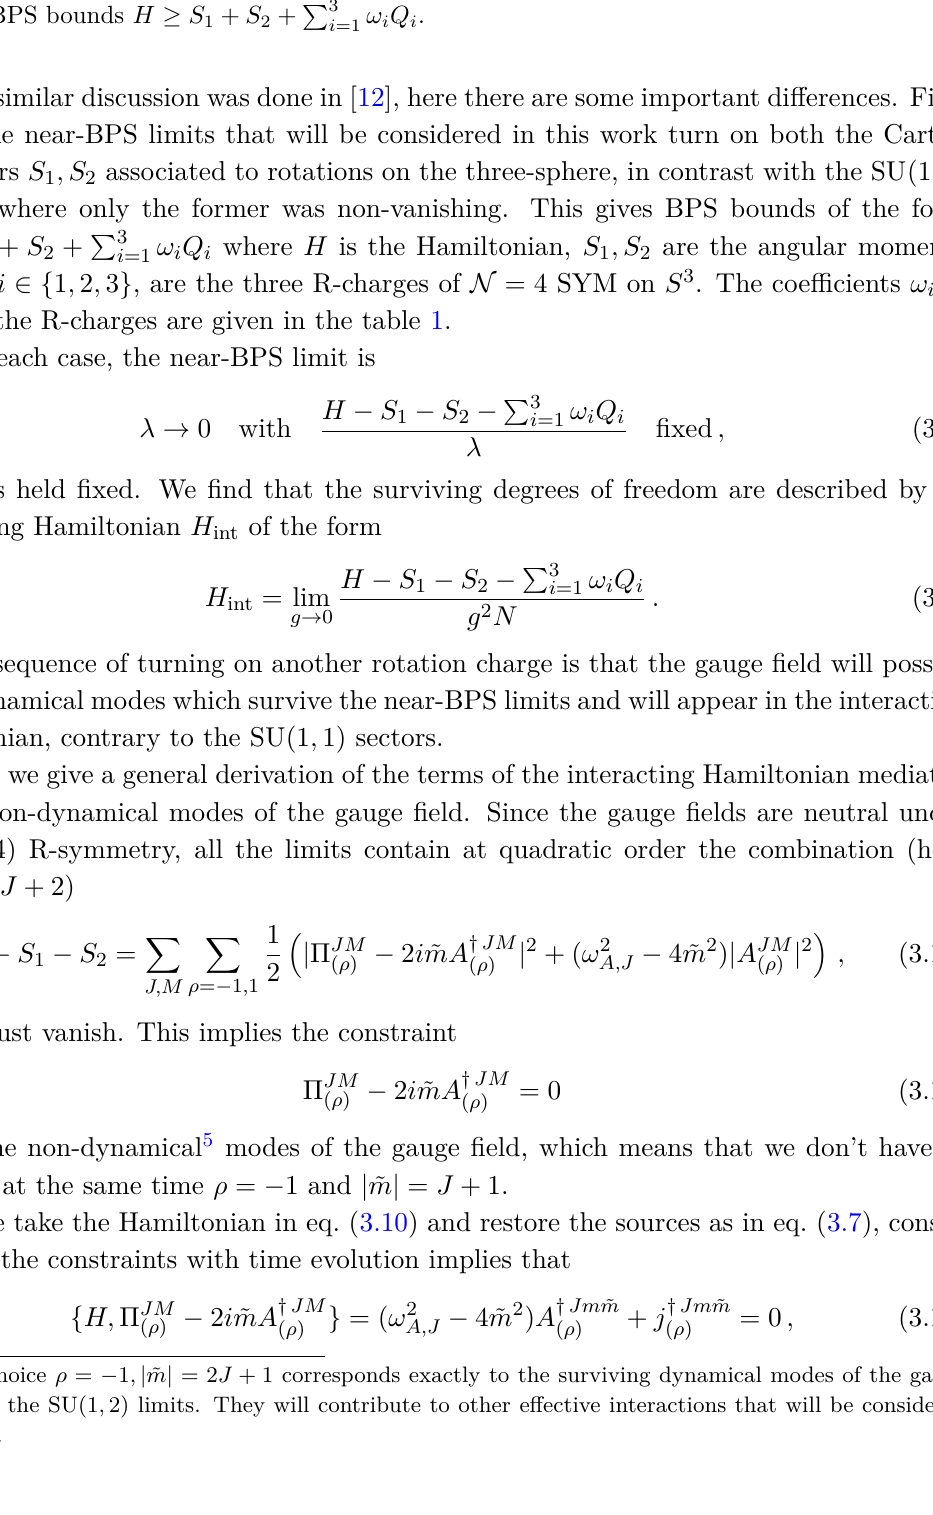
Table 1. List of the combinations of the R-charges defining the limits of N = 4 SYM theory towards BPS bounds H ≥ S